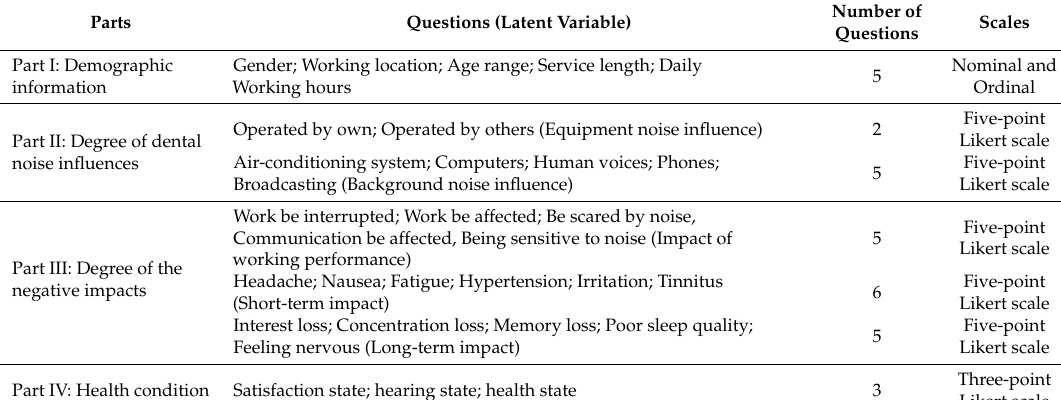
Table 1. Summary of the questions in the self-administrated questionnaire